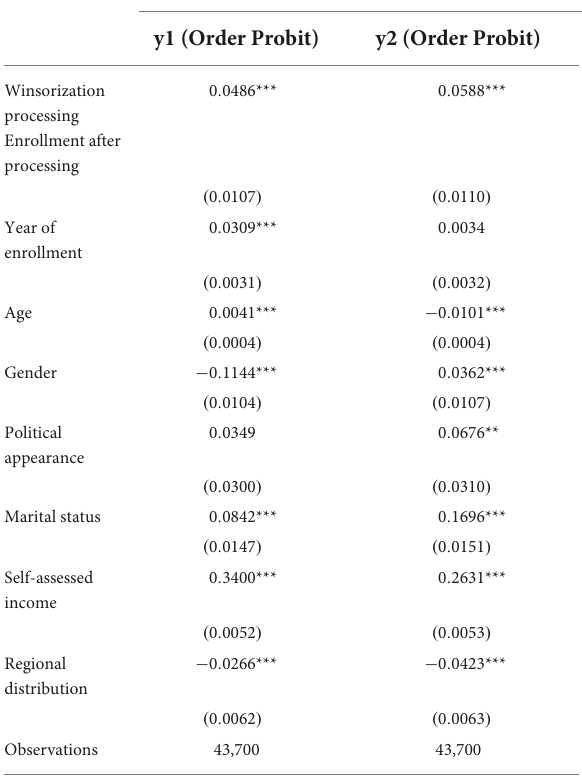
TABLE 5 Robustness test